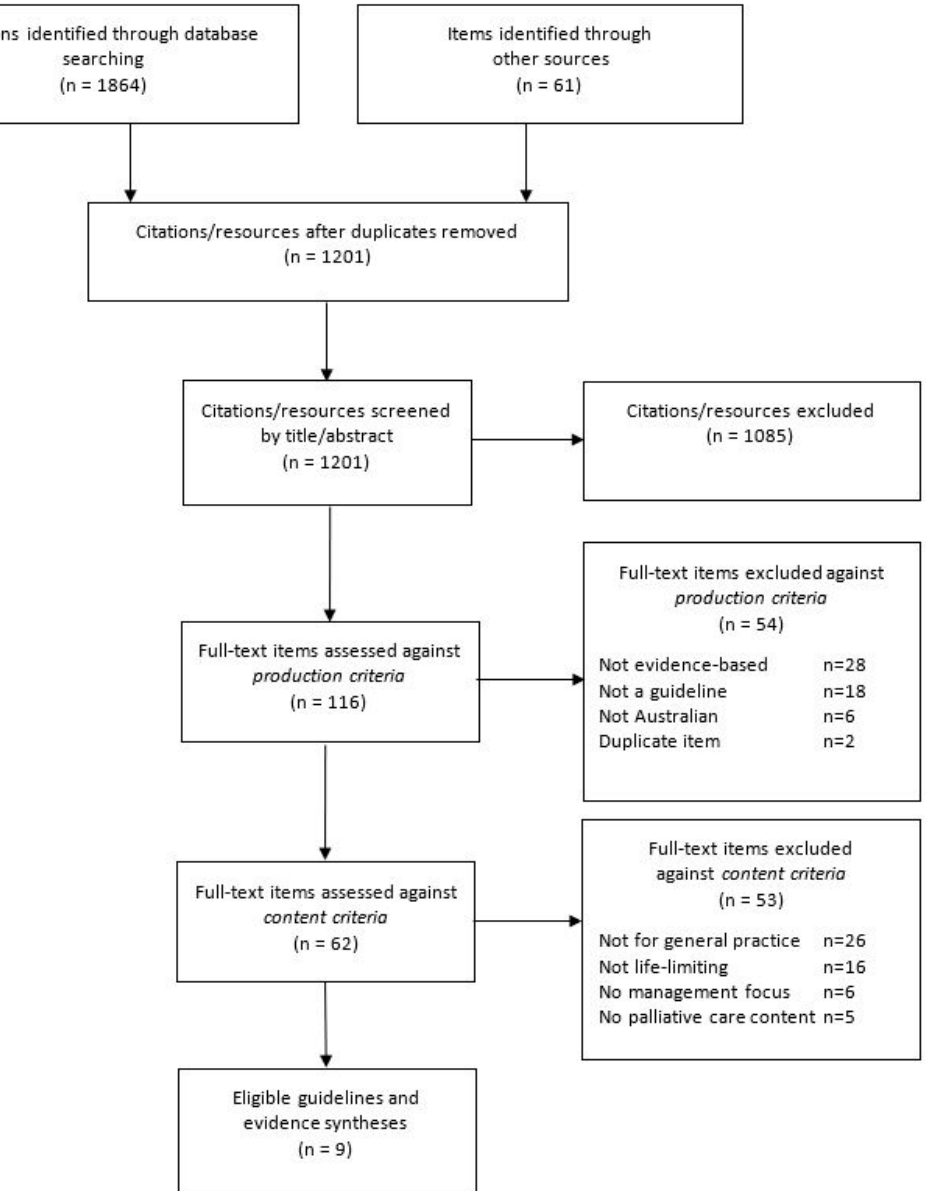
Figure 1. PRISMA flow diagram of the guideline selection process.